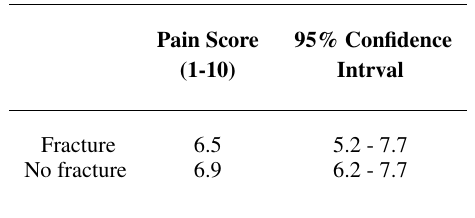
Table 4. Pain score mean in patients with and without ankle